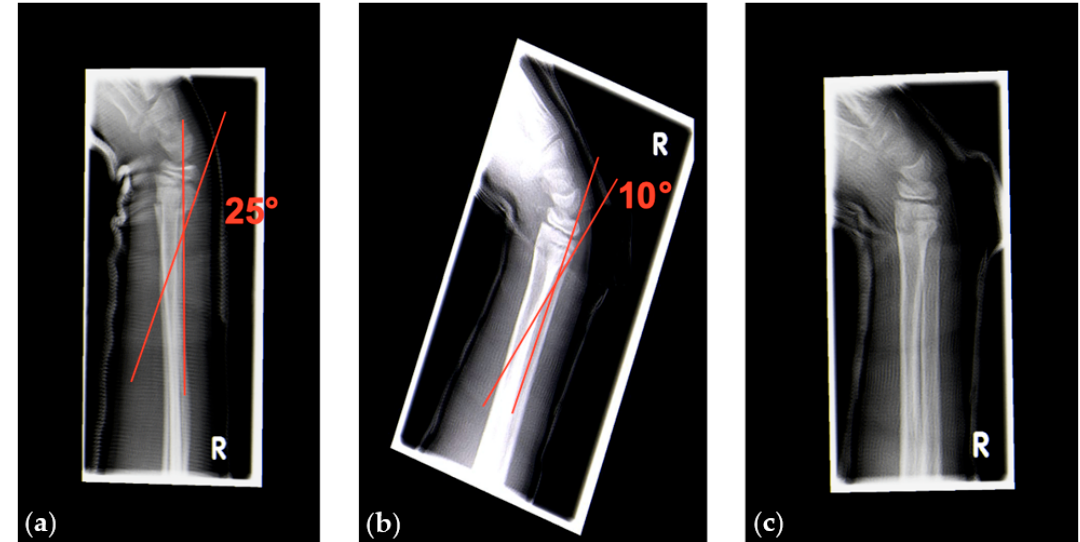
Figure 8. ( a ) Radiographic images of a sagittal 25° angular deformity of a dorsally displaced complete fracture of the distal radial metaphysis. ( b , c ) Angulation after cast wedging reduced by 15°, moving the deformity into the limits of sufficient spontaneous correction.